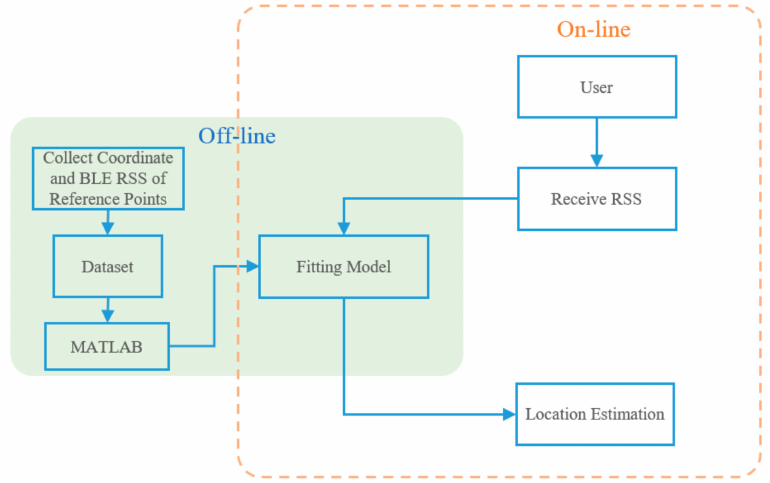
Figure 5. System Flowchart for This Study.